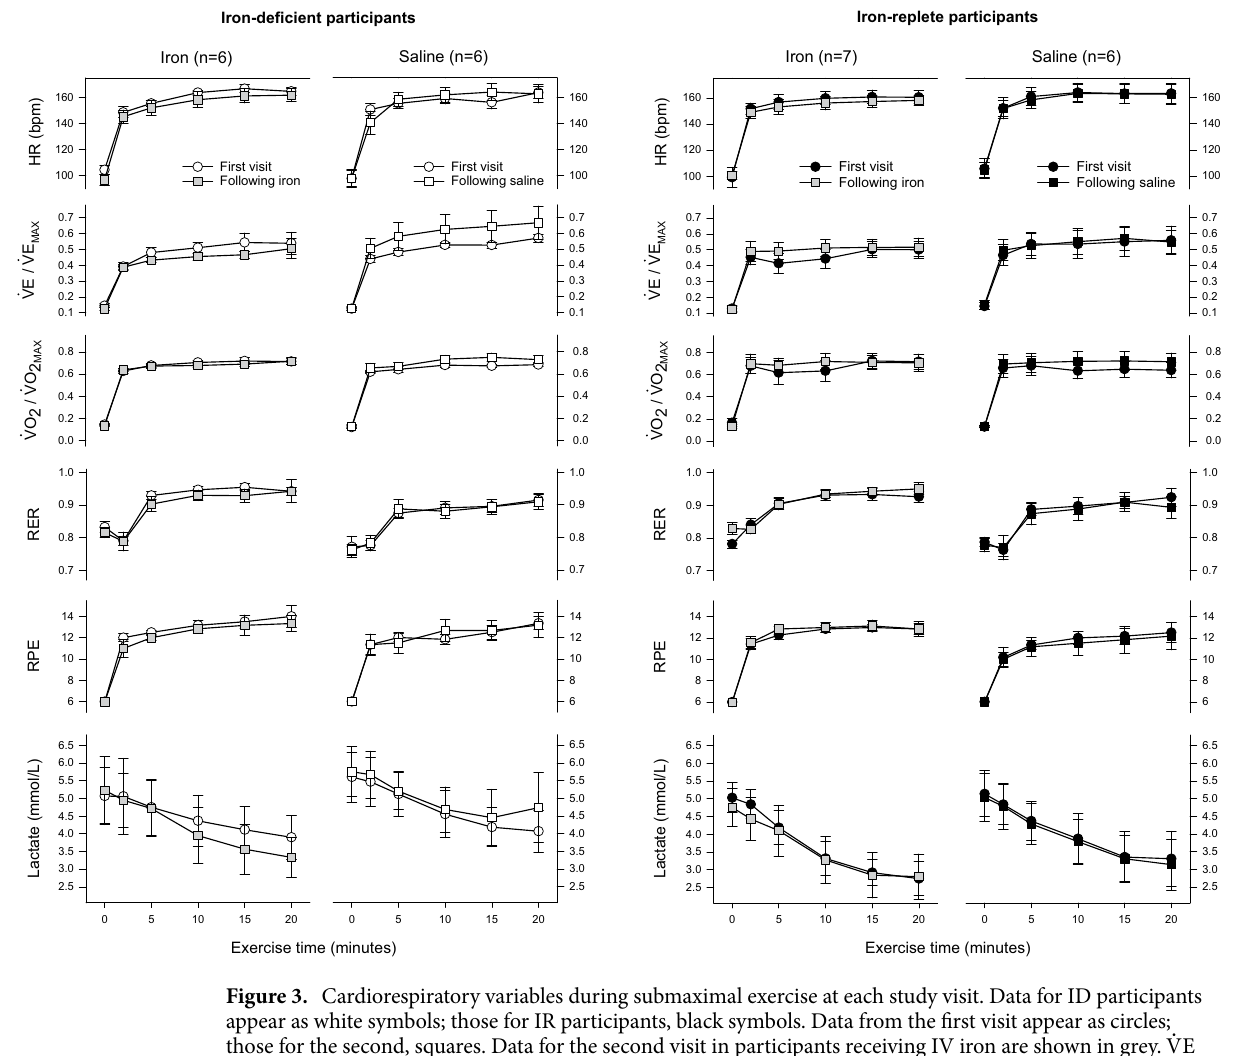
Figure 3. Cardiorespiratory variables during submaximal exercise at each study visit. Data for ID participants appear as white symbols; those for IR participants, black symbols. Data from the first visit appear as circles; ˙ V those for the second, squares. Data for the second visit in participants receiving IV iron are shown in grey. E ˙ V and o 2 values for both visits are expressed relative to maximal values at the first visit. Values for parameters other than lactate are means for the previous 30 s; error bars show SE. One ID participant became presyncopal after volitional fatigue at the second visit and did not perform submaximal exercise; data for this individual are ˙ V ˙ V excluded from the figure (but not the statistical analysis). Data at the first visit for E, o 2 and RER at the 10, 15 and 20-min time points were missing for one IR participant randomised to receive saline due to a technical issue. P = 0.028 for differential effect of IV iron according to baseline iron status; comparisons for all other ˙ V variables NS. HR, heart rate; E, minute ventilation; RER, respiratory exchange ratio; RPE, rating of perceived exertion.